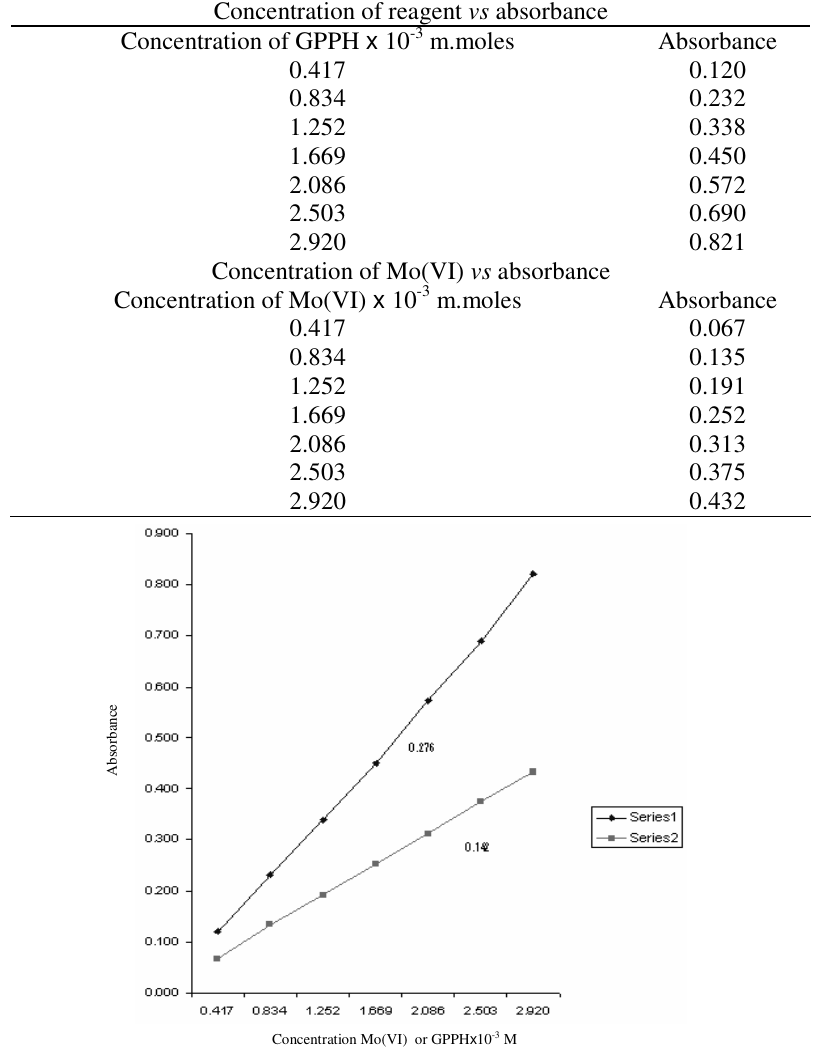
Figure 5. Slope ratio method series1. Concentration GPPH vs. absorbance series 2. Concentration Mo(VI) vs.